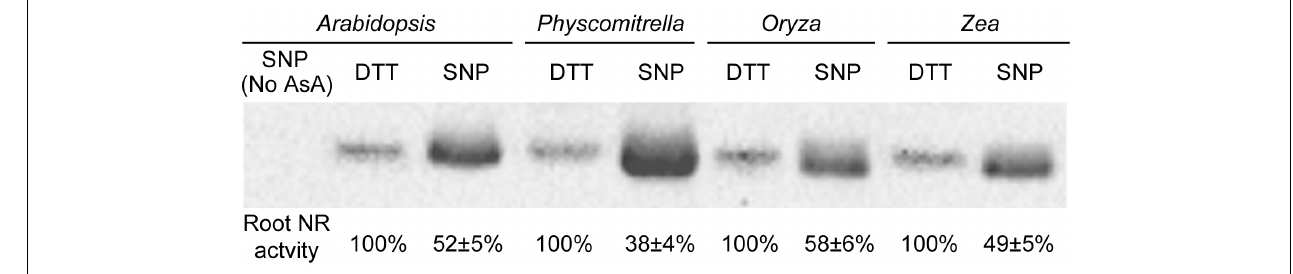
FIGURE 2 | S -Nitrosylation levels and root enzyme activities of nitrate reductase from four plant species. The 14-day-old Arabidopsis thaliana , Physcomitrella patens , Oryza sativa and Zea mays seedlings treated grown with or without 0.2 mM SNP (sodium nitroprusside; a NO donor) or 2 mM DTT (dithiothreitol; a NO inhibitor) were harvested for protein extraction. Total cellular proteins were extracted with HEN buffer (250 mM Hepes-NaOH pH 7.7, 1 mM EDTA, 0.1 mM neocuproine and proteinase inhibitor cocktail). After placing on ice for 20 min, the homogenate was centrifuged at 4 ◦ C at 14,000 rpm for 5 min. The supernatant was placed into a new tube and centrifuged it at 4 ◦ C at 14,000 rpm for 15 min. About 200 µ g total cellular proteins were diluted into 125 µ l HEN buffer with 500 µ l blocking buffer [2.5% SDS and 20 mM methylmethane thiosulphonate (MMTS) in HEN buffer]. After 60 min incubation in 50 ◦ C under continuous shaking, MMTS was removed by acetone precipitation. The protein was diluted with 100 µ l HEN buffer plus 1% SDS. The labeling reaction was initiated by adding 25 µ l of 400 µ M sodium ascorbate and 25 µ l biotin-M (Sigma-Aldrich) and incubating at 25 ◦ C 2 h on a shaker. All proteins after biotin-switch were immunoprecipitated with the biotin antibody (Abcam), and then were subjected to Western blotting with the Arabidopsis NR antibody (Agrisera: AS08 310). 1/10 of the immunoprecipitated proteins (corresponding to 20 µ g total cellular proteins) were loaded into each lane (Zhang et al., 2017). Biotin-switch assay and Western blotting were repeated 3 times, and typical results were presented. Protein extracts without ascorbate treatments were used as the negative control (No AsA). The NR activity was measured by mixing 1 volume of protein extracts with 5 volumes of pre-warmed (25 ◦ C) assay buffer (100 mM HEPES-KOH, pH 7.5, 5 mM KNO 3 , and 0.25 mM NADH). The reaction was started by the addition of assay buffer, incubated at 25 ◦ C for 30 min, and then stopped by adding 0.1 M zinc acetate. After 15 min, the tubes were centrifuged at 13,000 × g for 5 min. The nitrite produced was measured at 520 nm by adding 1 mL of 1% (w/v) sulfanilamide in 3 M HCl plus 1 mL of 0.02% (v/v) N-(1-naphthyl)-ethylenediamine (Hu et al., 2015). Root NR activity of each plant treated with DTT was normalized to 100%. Enzyme activities under the SNP treatment are shown as mean ± standard deviations ( n =